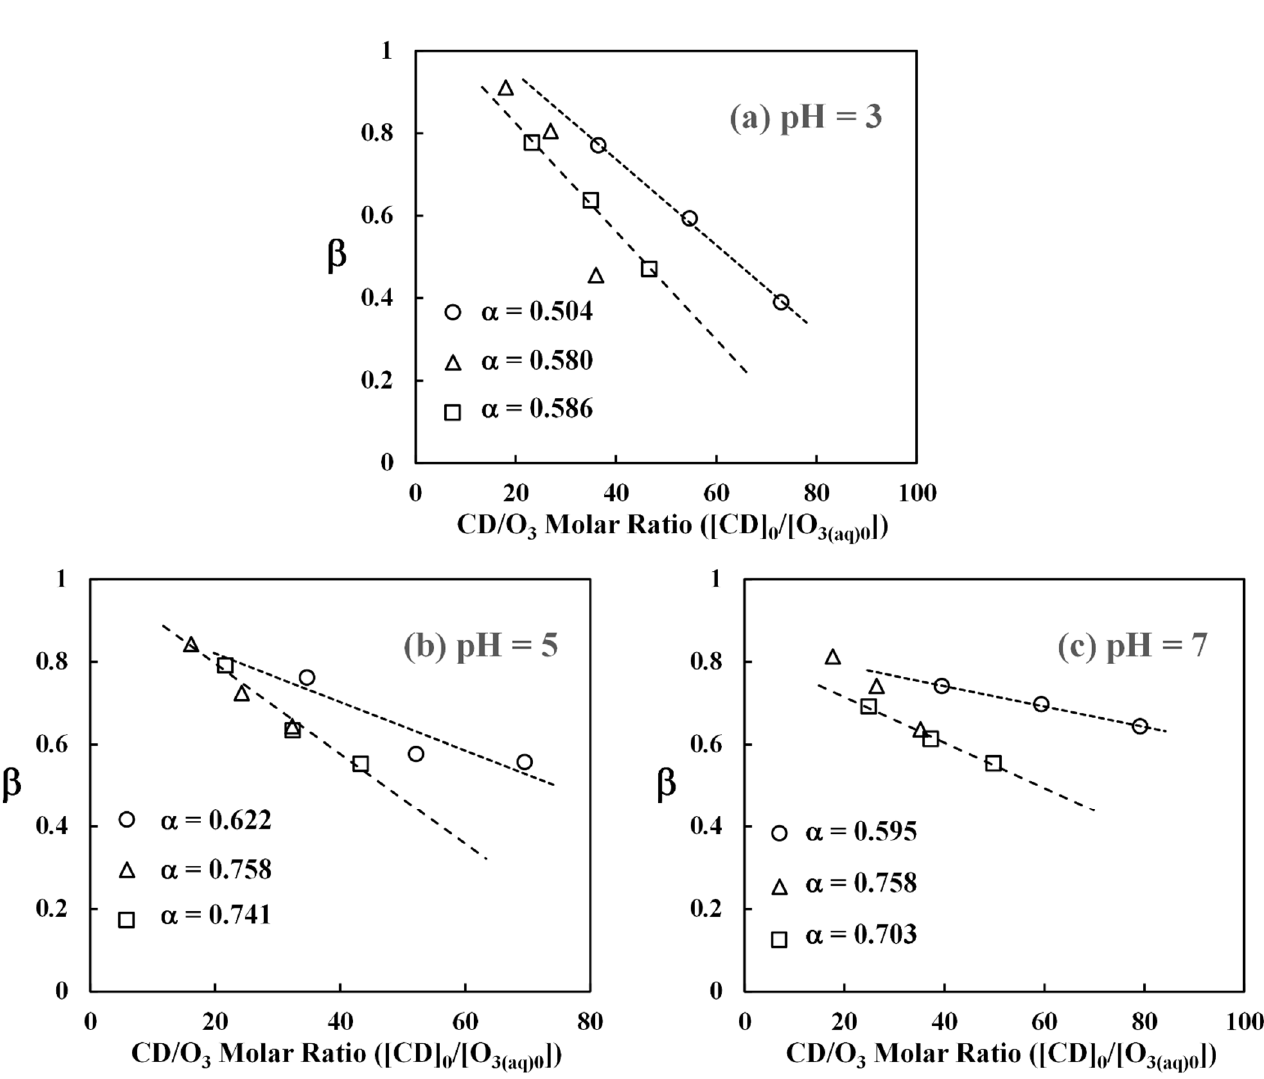
Figure 3. Dimensionless plots of β as a function of CD/O 3 molar ratio ( [𝐶𝐷] (cid:2868) [⁄ 𝑂 (cid:2871)((cid:3028)(cid:3044))(cid:2868) ] ) under various α values in the dynamic equilibrium O 3 - β CD system at three different pH values: ( a ) pH = 3; ( b ) pH = 5; ( c ) pH = 7.